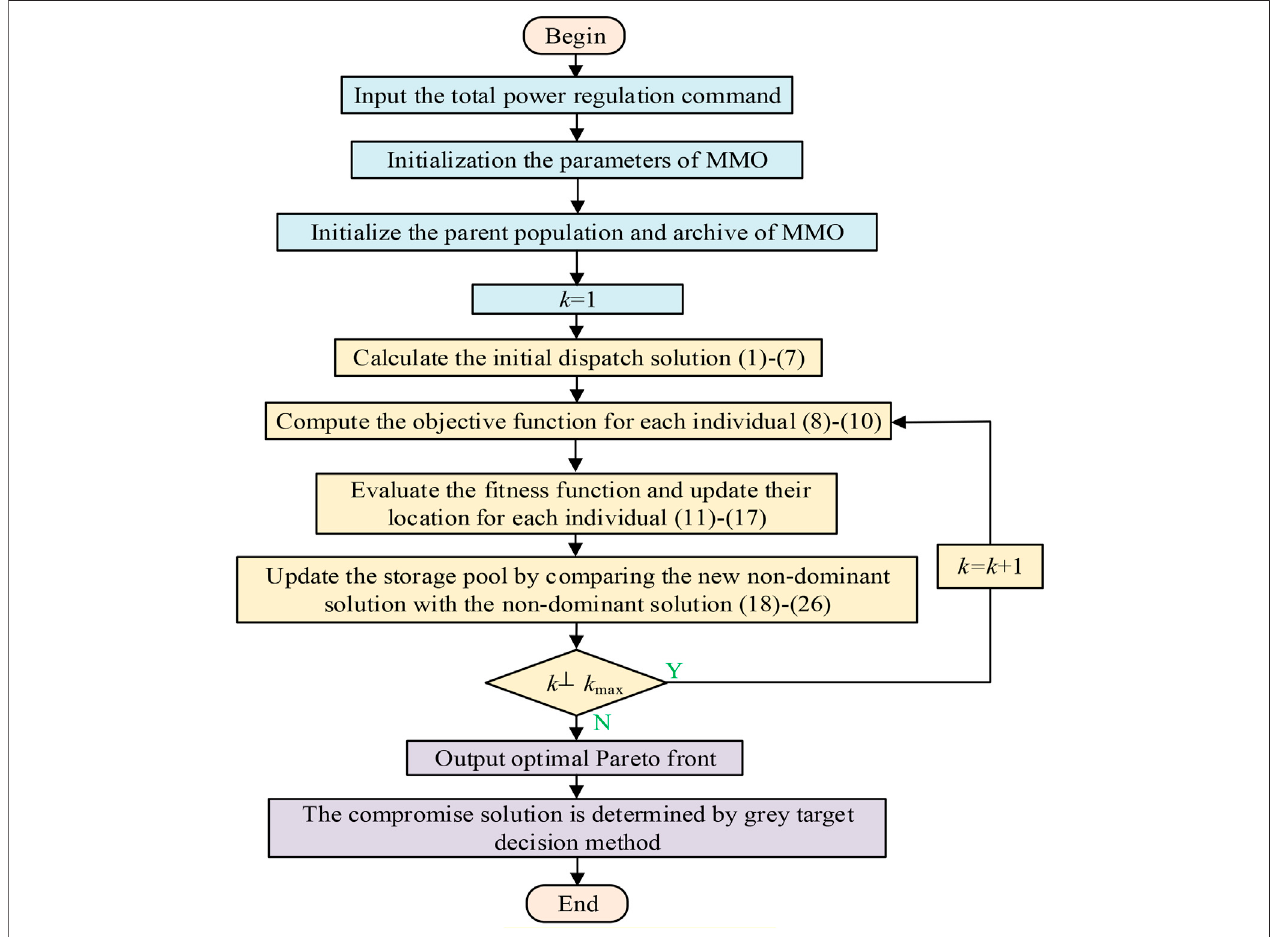
FIGURE 4 | Flowchart of MMO.